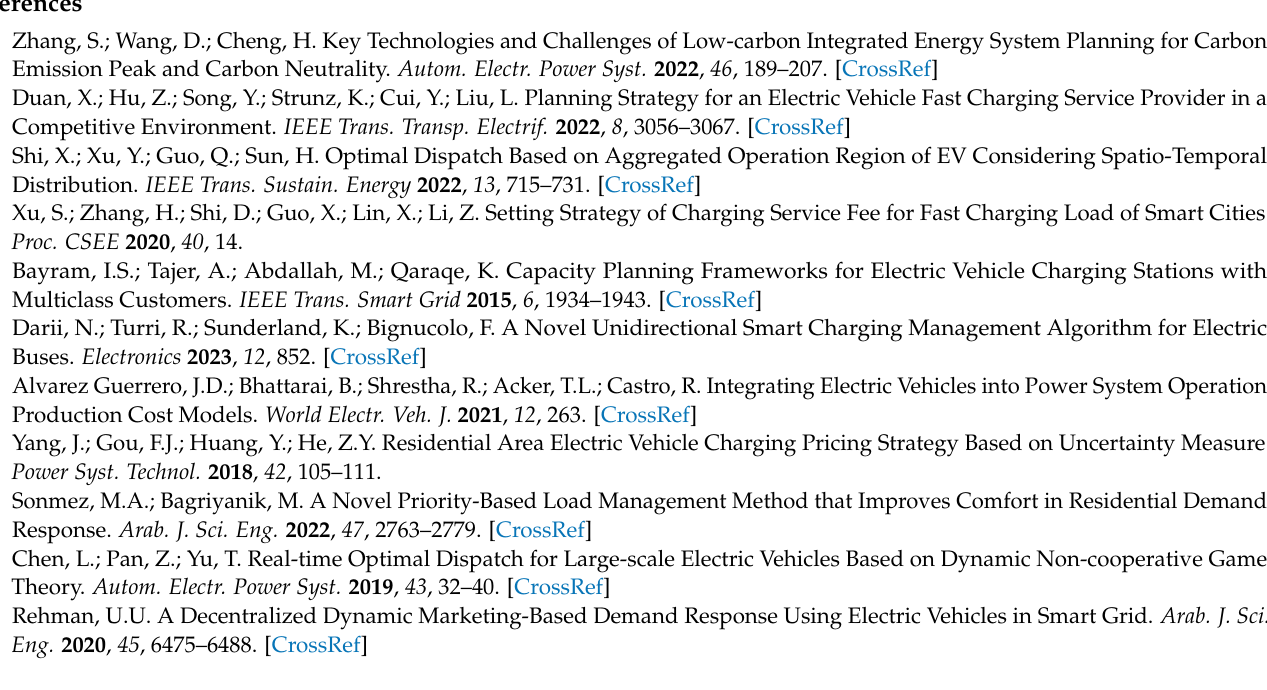
Figure A1. ( a ) Initial position distribution of EVs; ( b ) Departure time distribution of EVs.